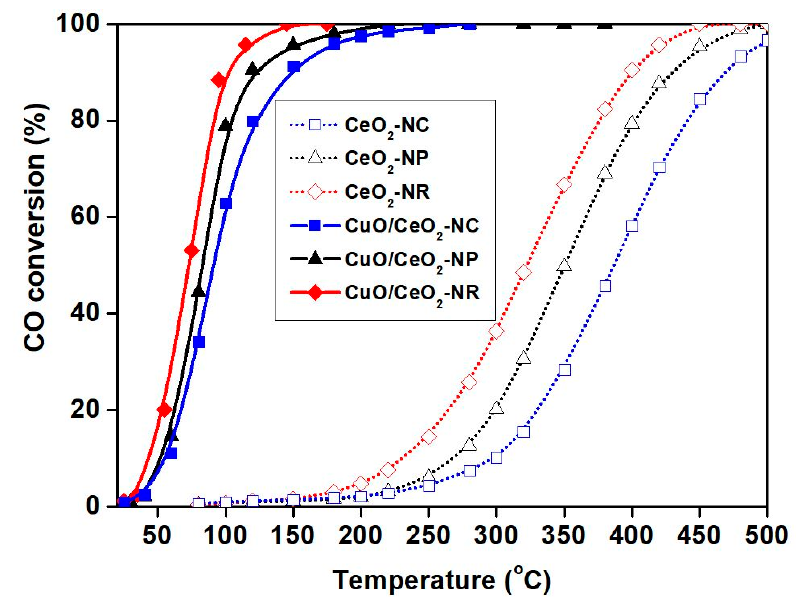
Figure 11. CO conversion as a function of temperature for bare CeO 2 and CuO x /CeO 2 samples of different morphology (NR, NC and NP, as indicated in each curve). Reaction conditions: 2000 ppm CO, 1 vol.% O 2 , GHSV = 39,000 h − 1 [115].